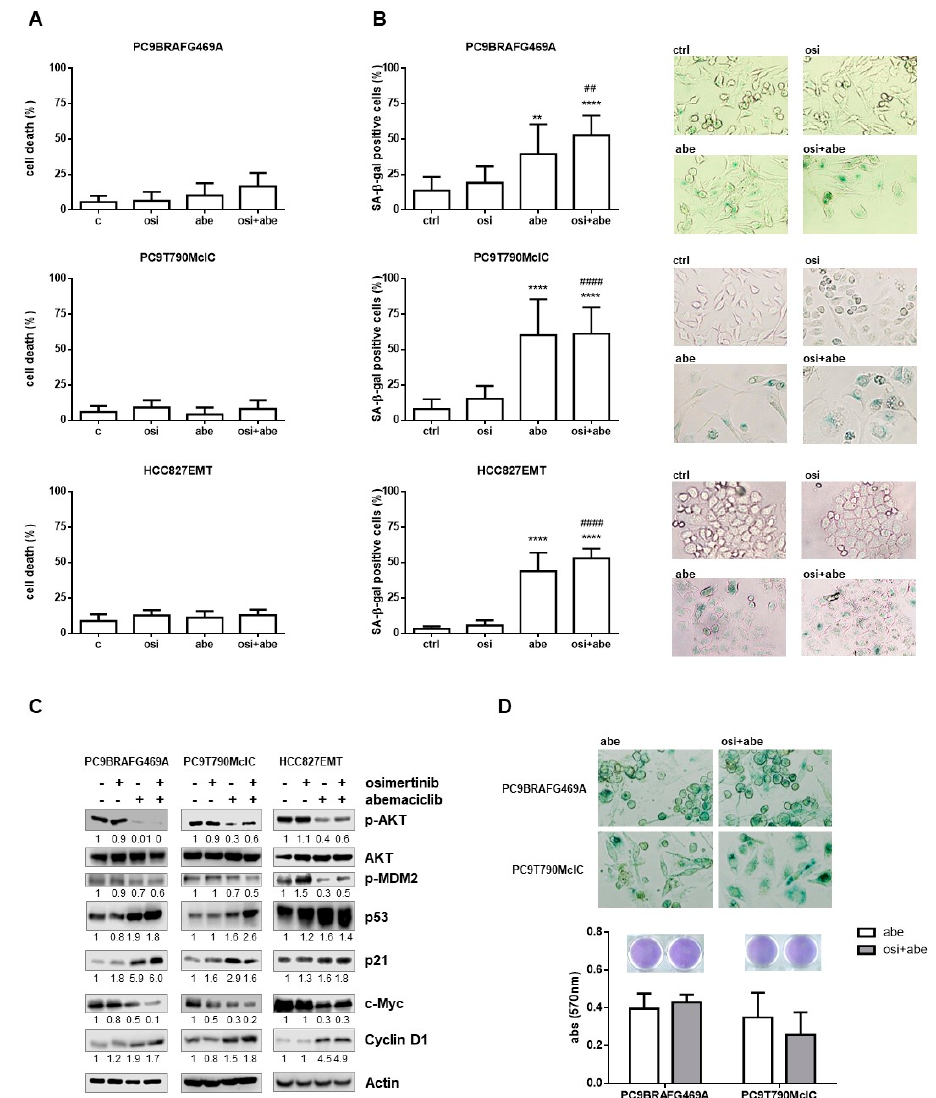
Figure 5. Effect of abemaciclib alone or combined with osimertinib on cell death and senescence in NSCLC osimertinib resistant cell lines. Cells were treated with 500 nM osimertinib, 500 nM abemaciclib or their combination for 72 h. ( A ) Cell death was quantified by fluorescence microscopy analysis on Hoechst 33342 and propidium iodide-stained cells. Data are representative of two independent experiments. ( B ) Senescent cells were quantified by SA- β -Gal staining. Histograms represent the percentage of senescent cells positive for SA- β -Gal expression and are means ± SD of data from three independent experiments. (** p < 0.01, **** p < 0.0001 vs. control; ## p < 0.01, #### p < 0.0001 vs. osimertinib). ( C ) The cells were lysed and western blot analysis was performed to detect the indicated proteins. Results are representative of two independent experiments. ( D ) PC9BRAFG469A and PC9T790MclC cells were treated with 500 nM abemaciclib in absence or presence of 500 nM osimertinib. After 4 weeks senescence was assessed by β -galactosidase staining and cell proliferation was evaluated by crystal violet staining. Columns are the means ± SD of 12 replicates. In ( B ) and ( D ), representative images of SA- β -Gal-stained cells are shown (magnification 100 ×